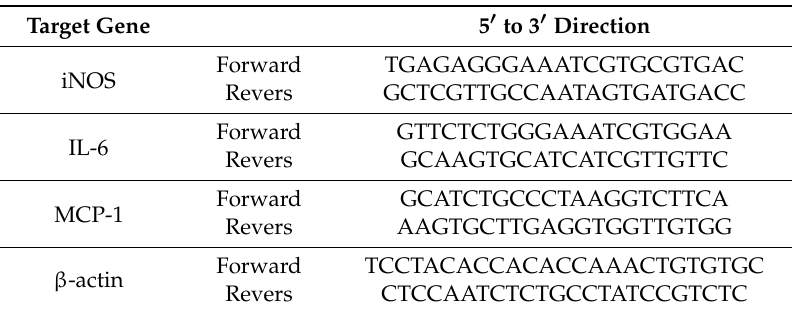
Table 1. Primers sequences for real-time PCR analysis. Target